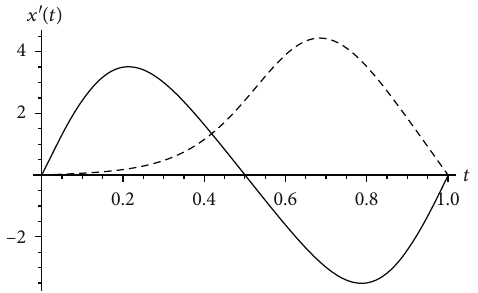
Figure 7: Graphs x ′ ð t Þ for solutions of problems (15) and (30) x α ≈ − 0 : 74 , x α ≈ − 1 : 4092